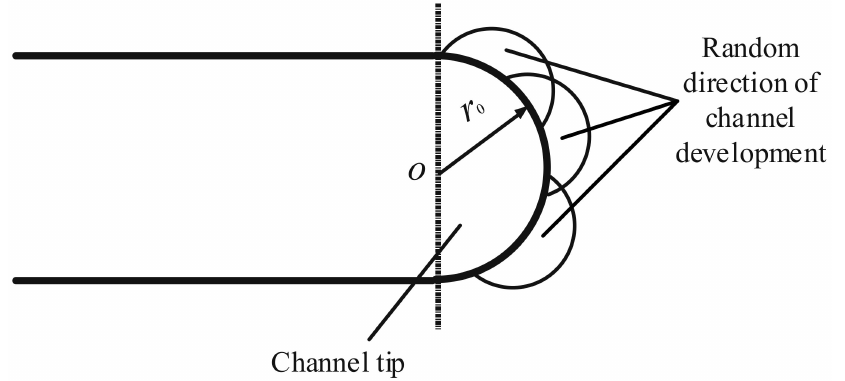
Figure 9. Schematic illustration of the progression trend for the pipe